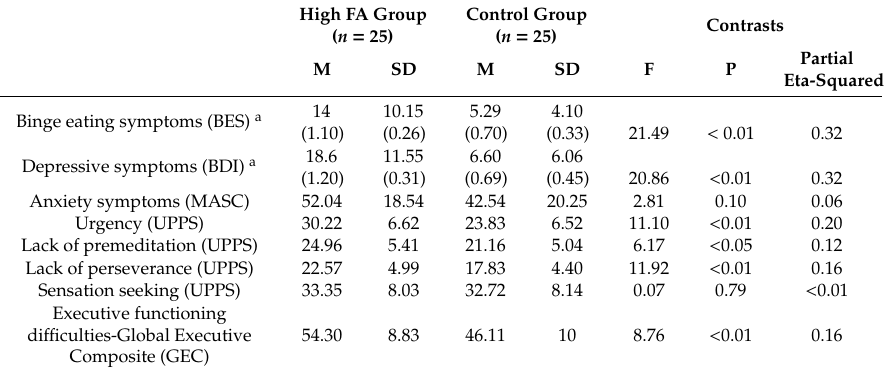
Table 1. Group comparisons–Self-reported variables (high FA group vs. control group).